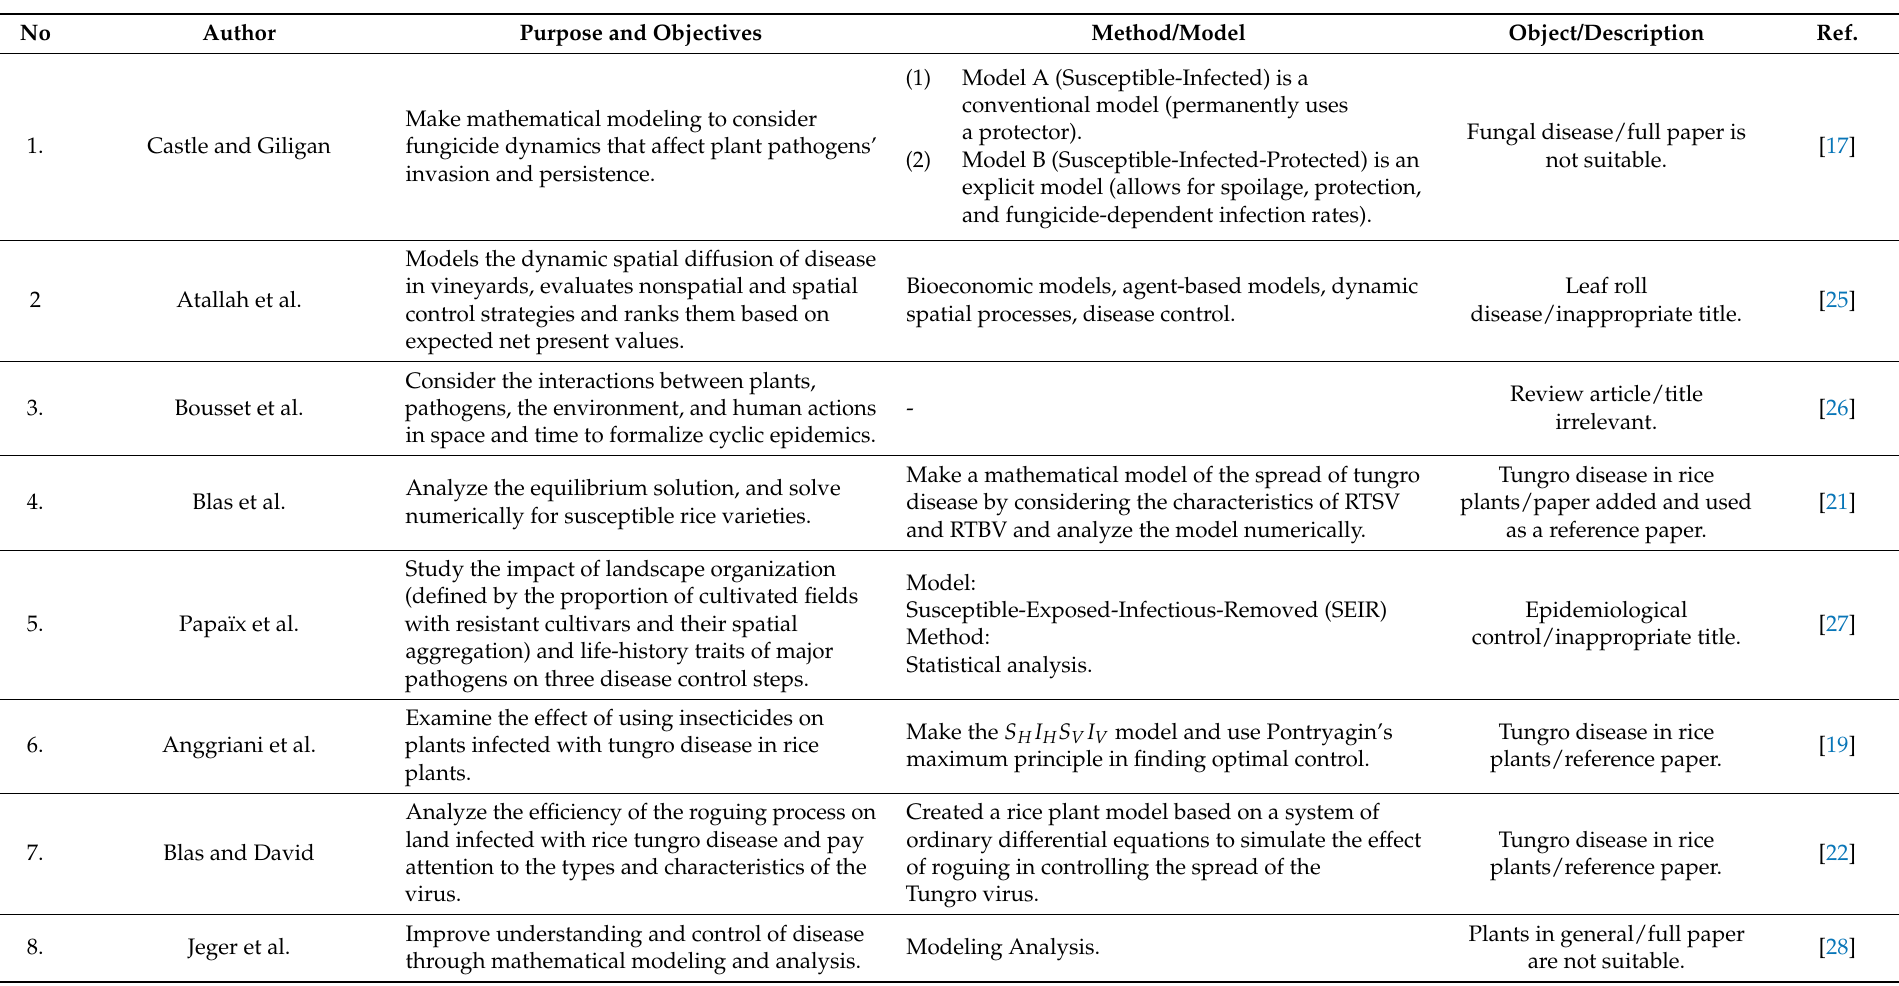
Table 2. Summary of relevant